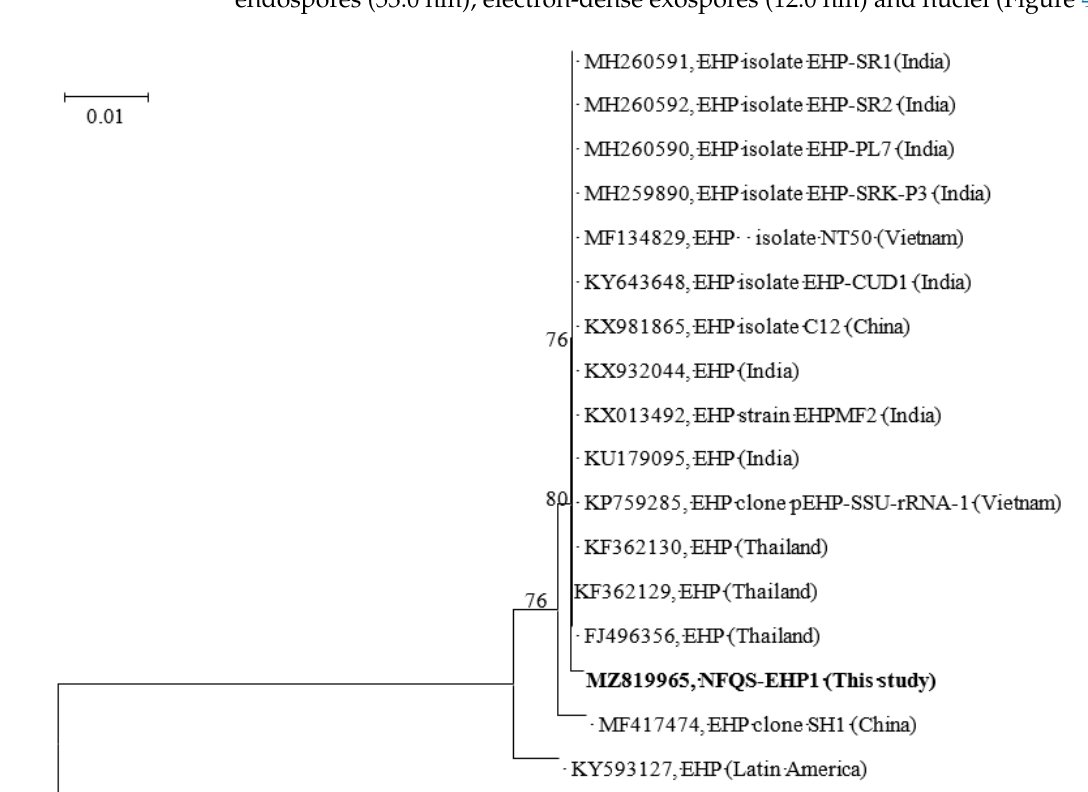
Figure 3. Hepatopancreas of Pacific whiteleg shrimp infected with EHP. ( A , B ) Hematoxylin and eosin staining revealing numerous eosinophilic EHP in the cytoplasm of epithelial cells in the hepatopancreas (ellipses) and edema in the intersti- tial tissue (asterisk). ( C , D ) Giemsa staining revealing numerous EHP (purple) in the cytoplasm of epithelial cells in the hepatopancreas (ellipses), along with EHP released into the lumen of the digestive tubule (arrows). 3.4. TEM Observation The TEM of the hepatopancreas revealed mature EHP ranging from 1.4 to 1.7 μ m in length with typical characteristics of coiled polar filaments, posterior vacuoles, polaro- plasts, endospores (53.0 nm), electron-dense exospores (12.0 nm) and nuclei (Figure 4).